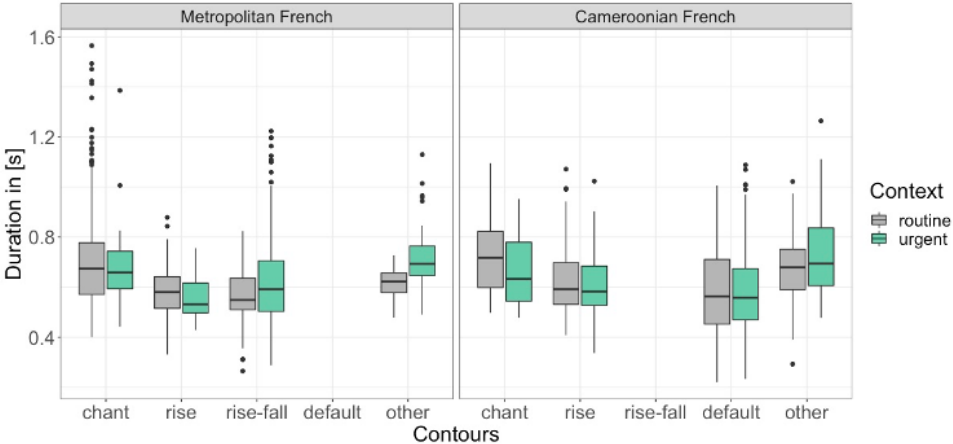
Figure 22. Word duration in the routine and urgent context across different calling melodies in MF and